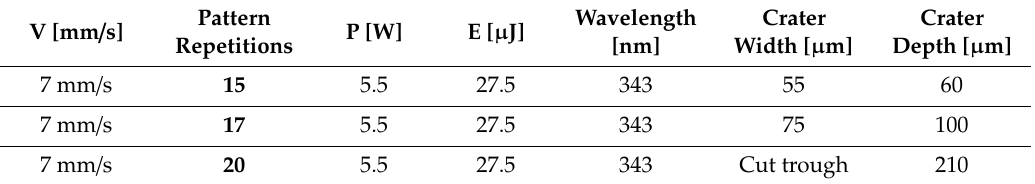
Table 2. Numerical results of Si micromachining.